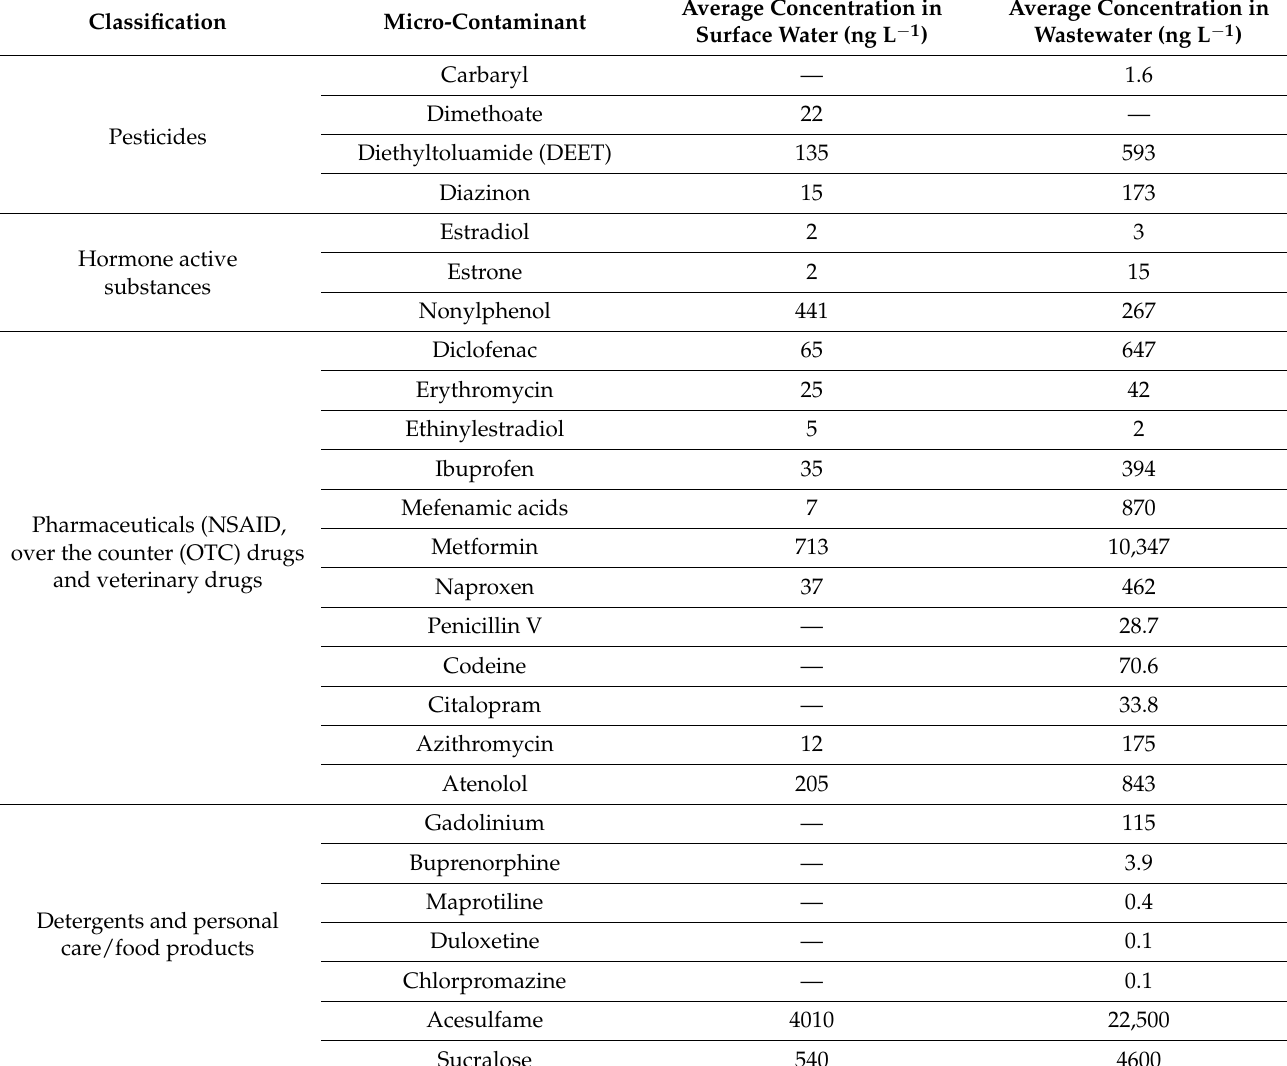
Table 1. Detailed information of the most common micro-contaminants in wastewater/surface water sources. Data were provided from the references [6,9,38,39].